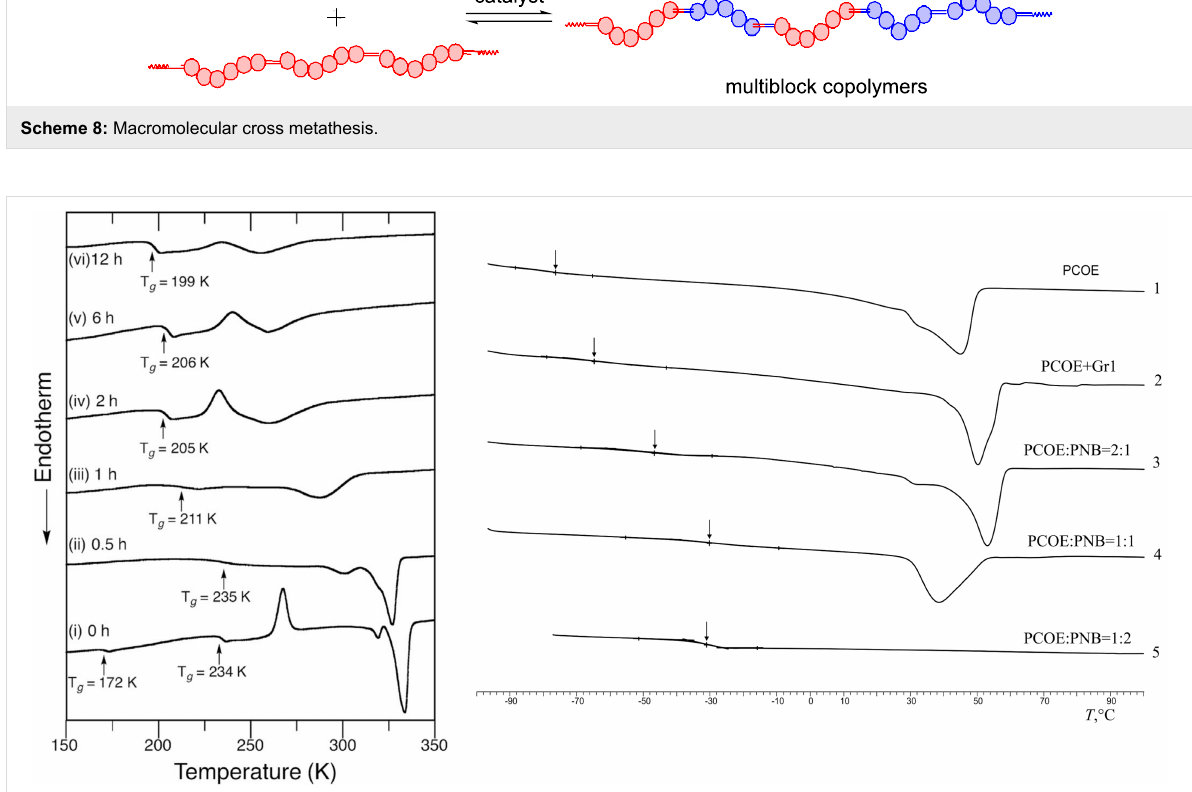
Figure 5: Changes in the DSC thermograms during MCM of PBD and polyesters (left) [84] and PNB–PCOE (right) mediated by Gr1 catalyst [89]. Arrows indicate the glass transition